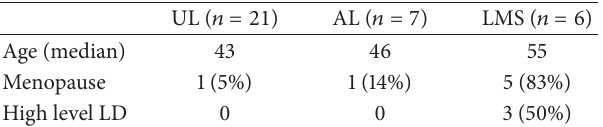
Table 3: Clinical features in